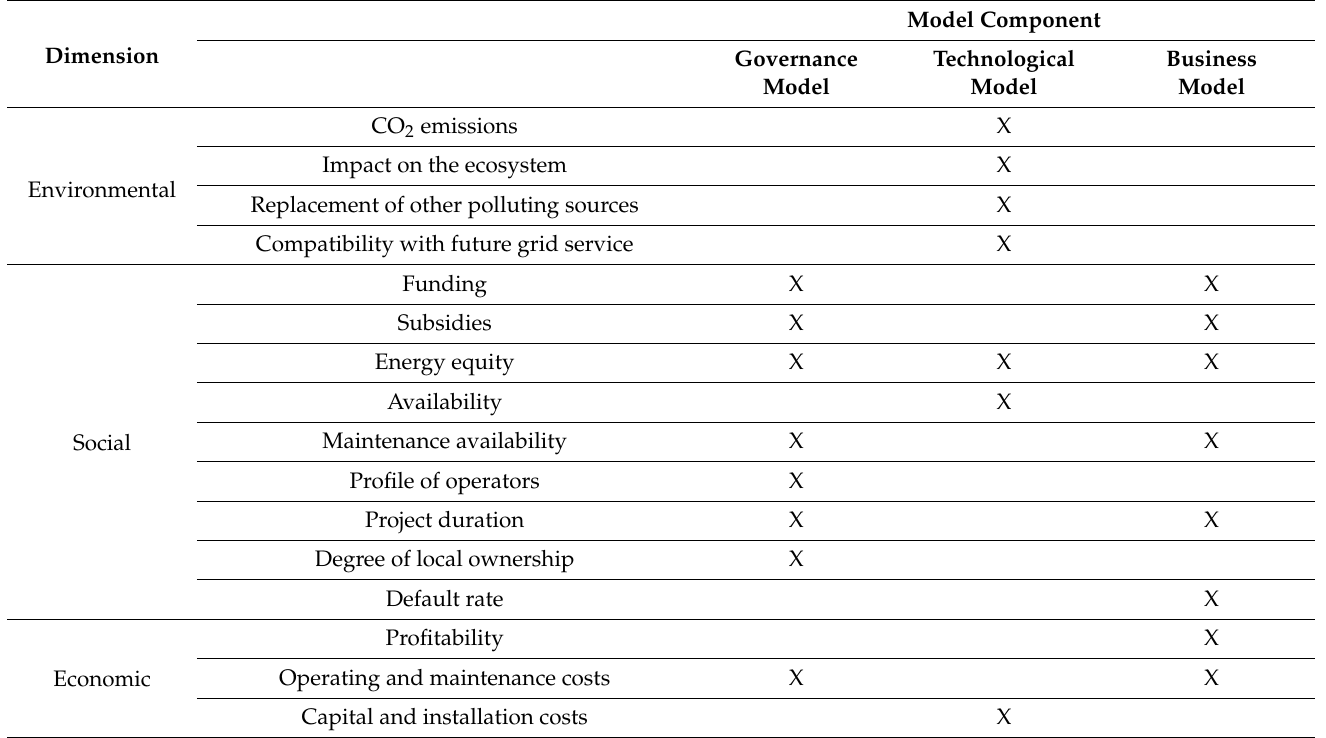
Table 1. Impact of decisions in the management model on sustainability in rural electrifica- tion